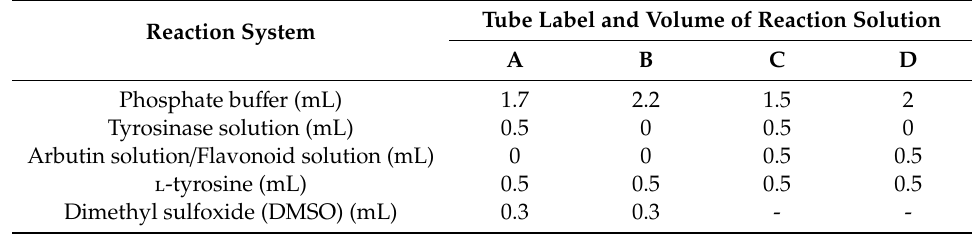
Table 7. The reaction systems of anti-tyrosinase